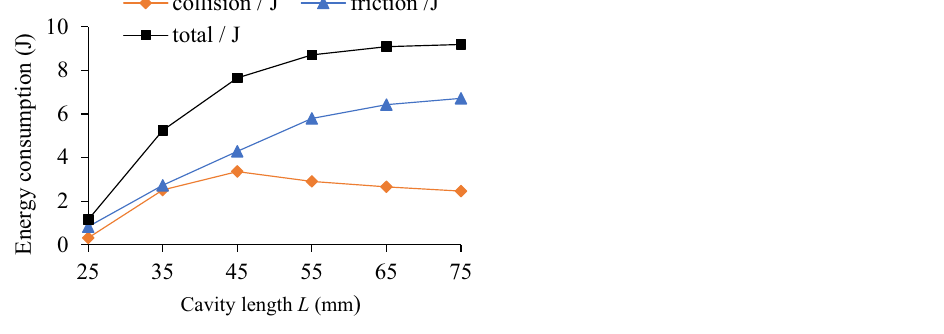
Figure 18. Influence of L on TEC.